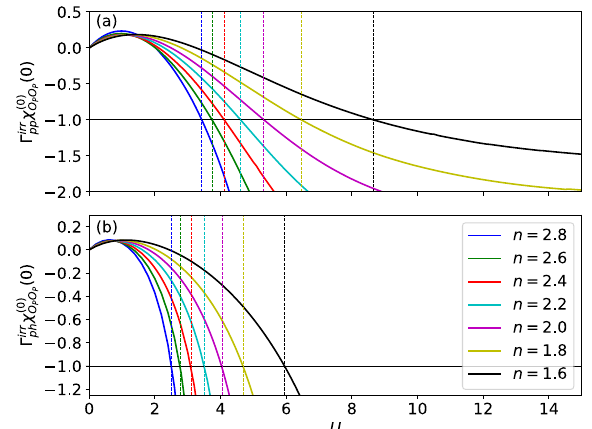
FIG. 7. (a) Irreducible particle-particle s -wave spin-triplet χ ð 0 Þ pairing vertex Γ irr as a function of Coulomb interaction U pp O P and J ¼ U= 4 for filling n ¼ 2 . 8 , 2.6, 2.4, 2.2, 2.0, 1.8, 1.6 and temperature T ¼ 0 . 0005 t . (b) Irreducible particle-hole s -wave χ ð 0 Þ spin-triplet pairing vertex Γ irr with the same parameter O P ph settings. The vertical dashed lines indicate the critical U c χ P − 1 , signalizing the divergence of determined from Γ irr 0 ¼ pp the superconducting susceptibility and the scattering